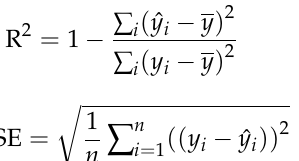
Figure 4. The tree crown detection of the pre- and transfer-trained Detectree2 methods derived from UAV-based RGB imagery in the studied temperate, deciduous forest. The green and orange bound- ing outlines indicate the predicted and ground truth tree crowns. 3.2. Accuracies of Tree Crown Detection Using Images with Different Spatial Resolutions The effects of different image spatial resolutions on the detection accuracy of tree crowns using both pre-trained and transfer-trained DeepForest from UAV RGB imagery are illustrated in Figure 5. In detail, the precision, recall, and F1 score of the pre-trained DeepForest method were low at 0.007 and 0.01 m resolutions but increased at a resolution of 0.02 m before varying slightly at resolutions ranging from 0.02 to 0.1 m. However, from resolutions of 0.1 to 0.5 m, the precision, recall, and F1 score declined rapidly and contin- uously. For the transfer-trained DeepForest method, the precision ranged from 0.49 to 0.61